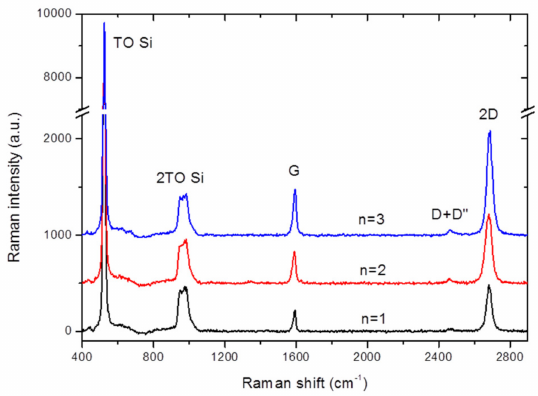
Figure 5. Raman spectra of a series of up to 3 GML stacked on top of the ITO / Si substrate system. The number of overlapping graphene layers (n) is indicated in each case. Spectra are vertically shifted for